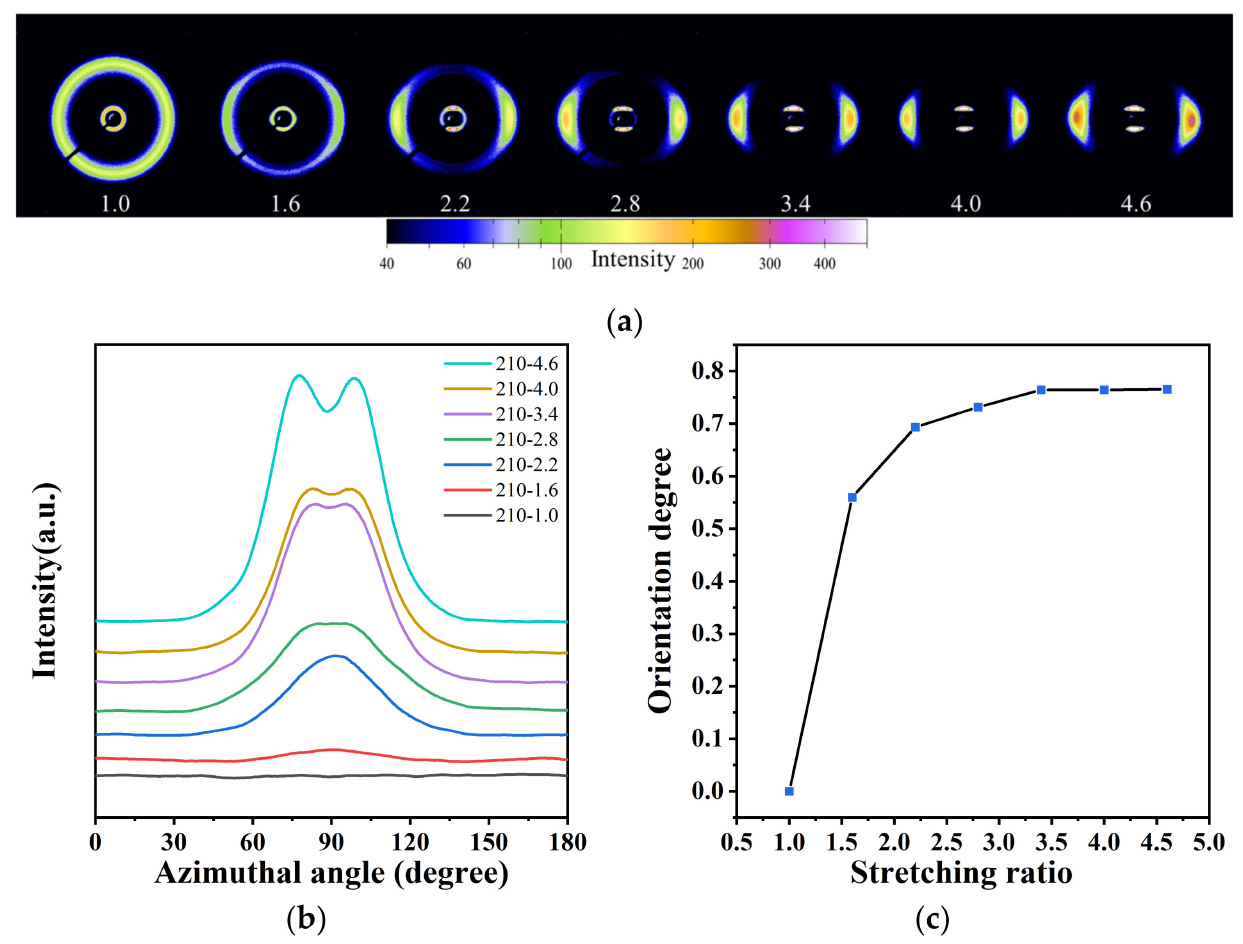
Figure 5. ( a ) 2D-WAXD diffraction patterns of PA12T samples with different stretching ratios; ( b ) azimuthal distribution of PA12T samples with different stretching ratios; ( c ) relationship between crystal orientation and stretching